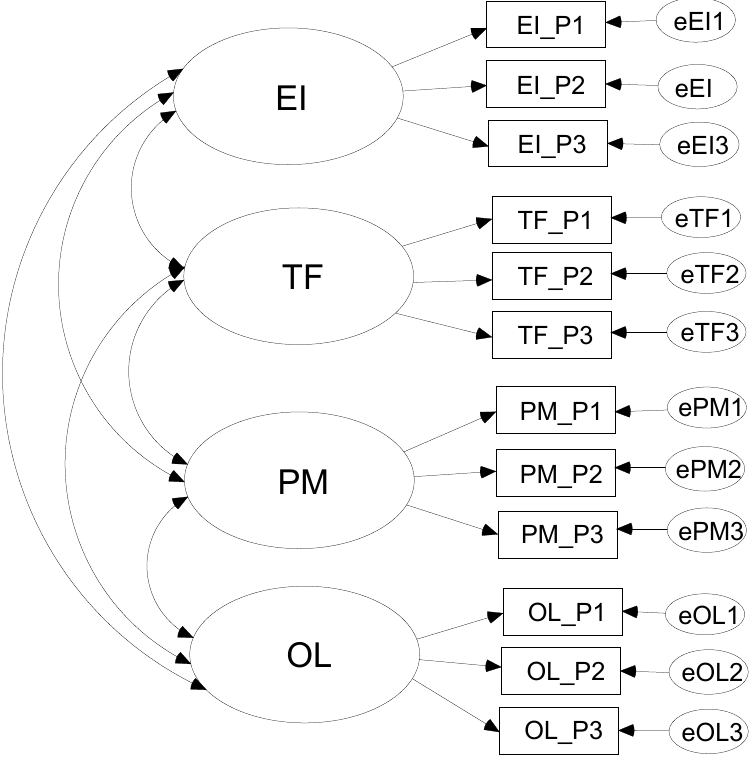
Figure 1. Measurement model for the Inventory of Adult Temperament